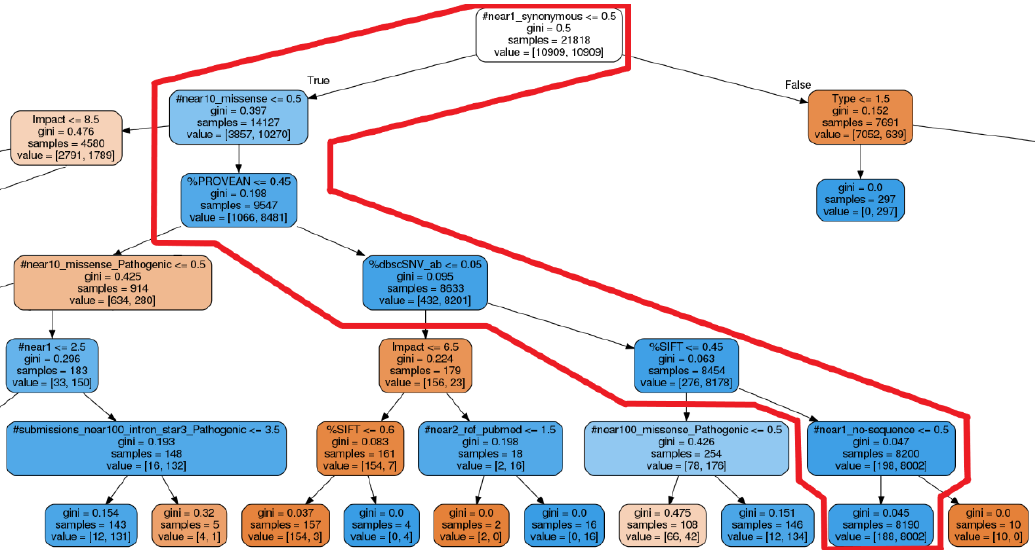
Figure 6. This is the decision trees model for the variant MYO7A NM_000260.4(MYO7A):c.5618G>A (p.Arg1873Gln) visualized using PyDotPlus (version 2.0.2). The paths circled in red are the subtrees that illustrate the case study. The red box was described manually. Several important nodes were enlarged for ease of viewing. This figure is an enlarged version of the red box area